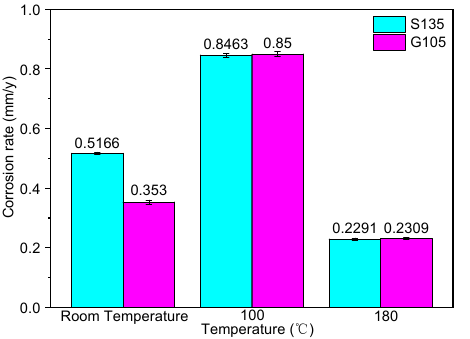
Figure 3. Corrosion rates of S135 and G105 drilling-pipe materials under different temperatures.